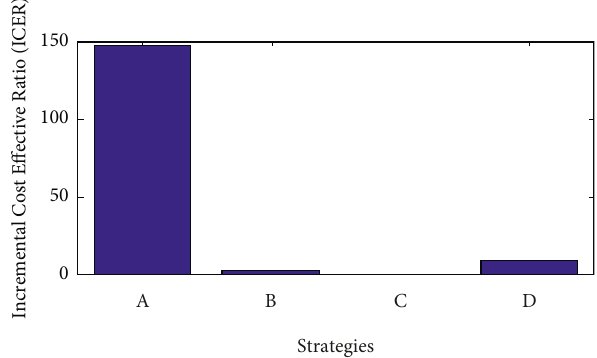
Figure 10: Comparison of the ICER of each control